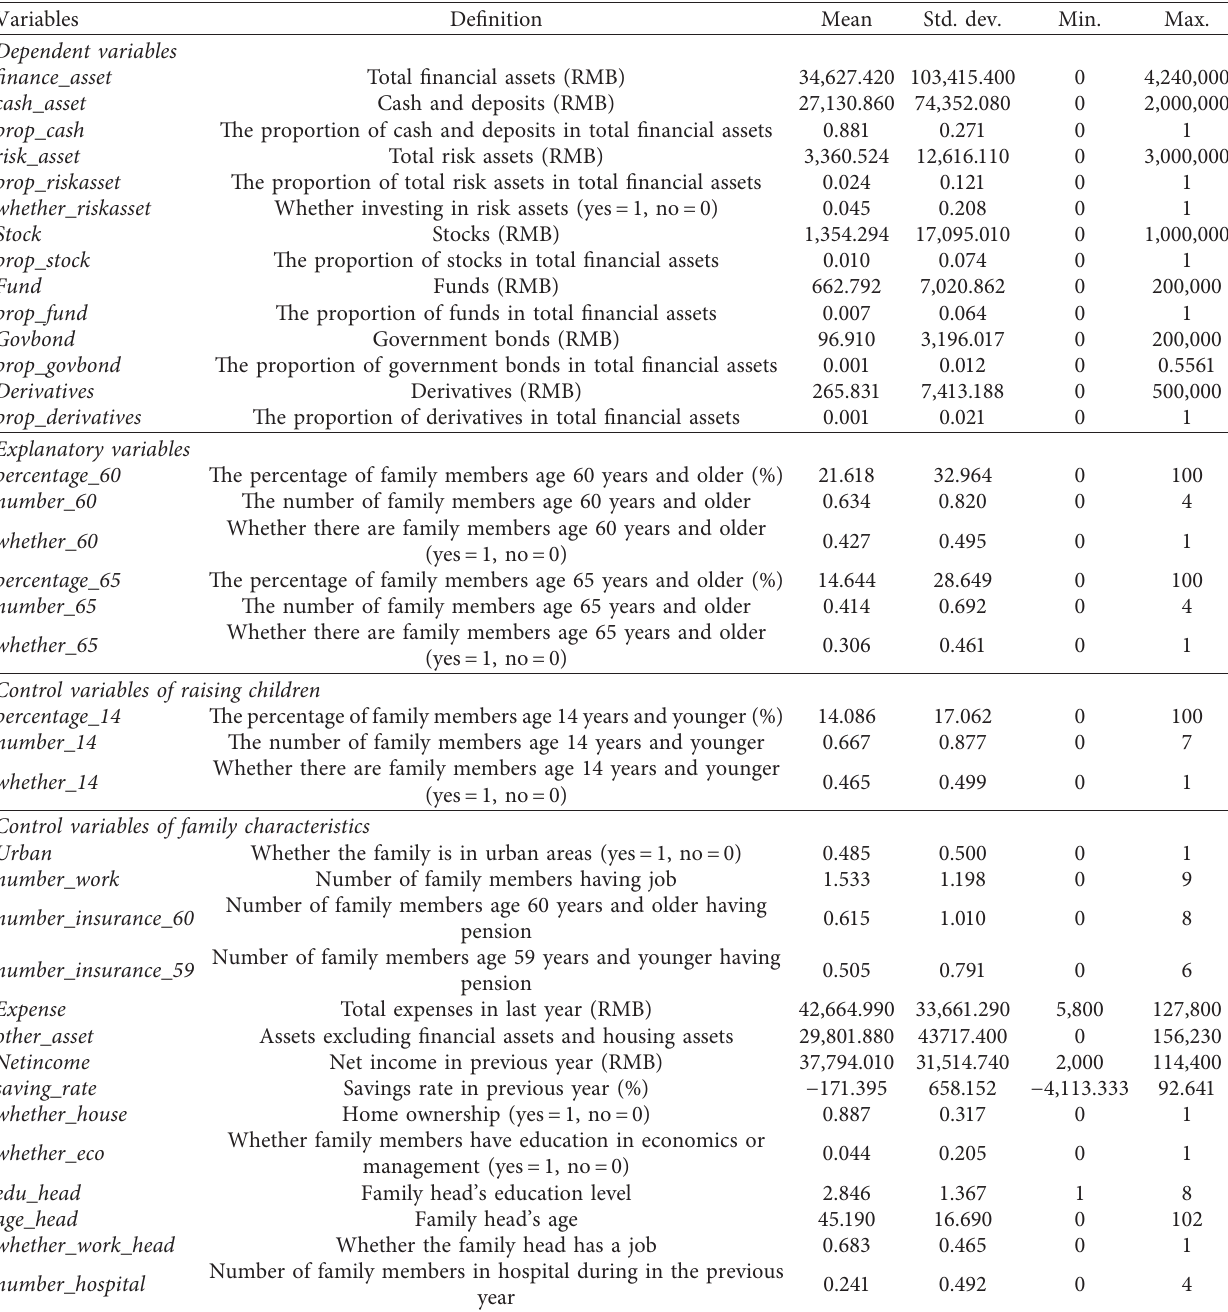
Table 2: Summary